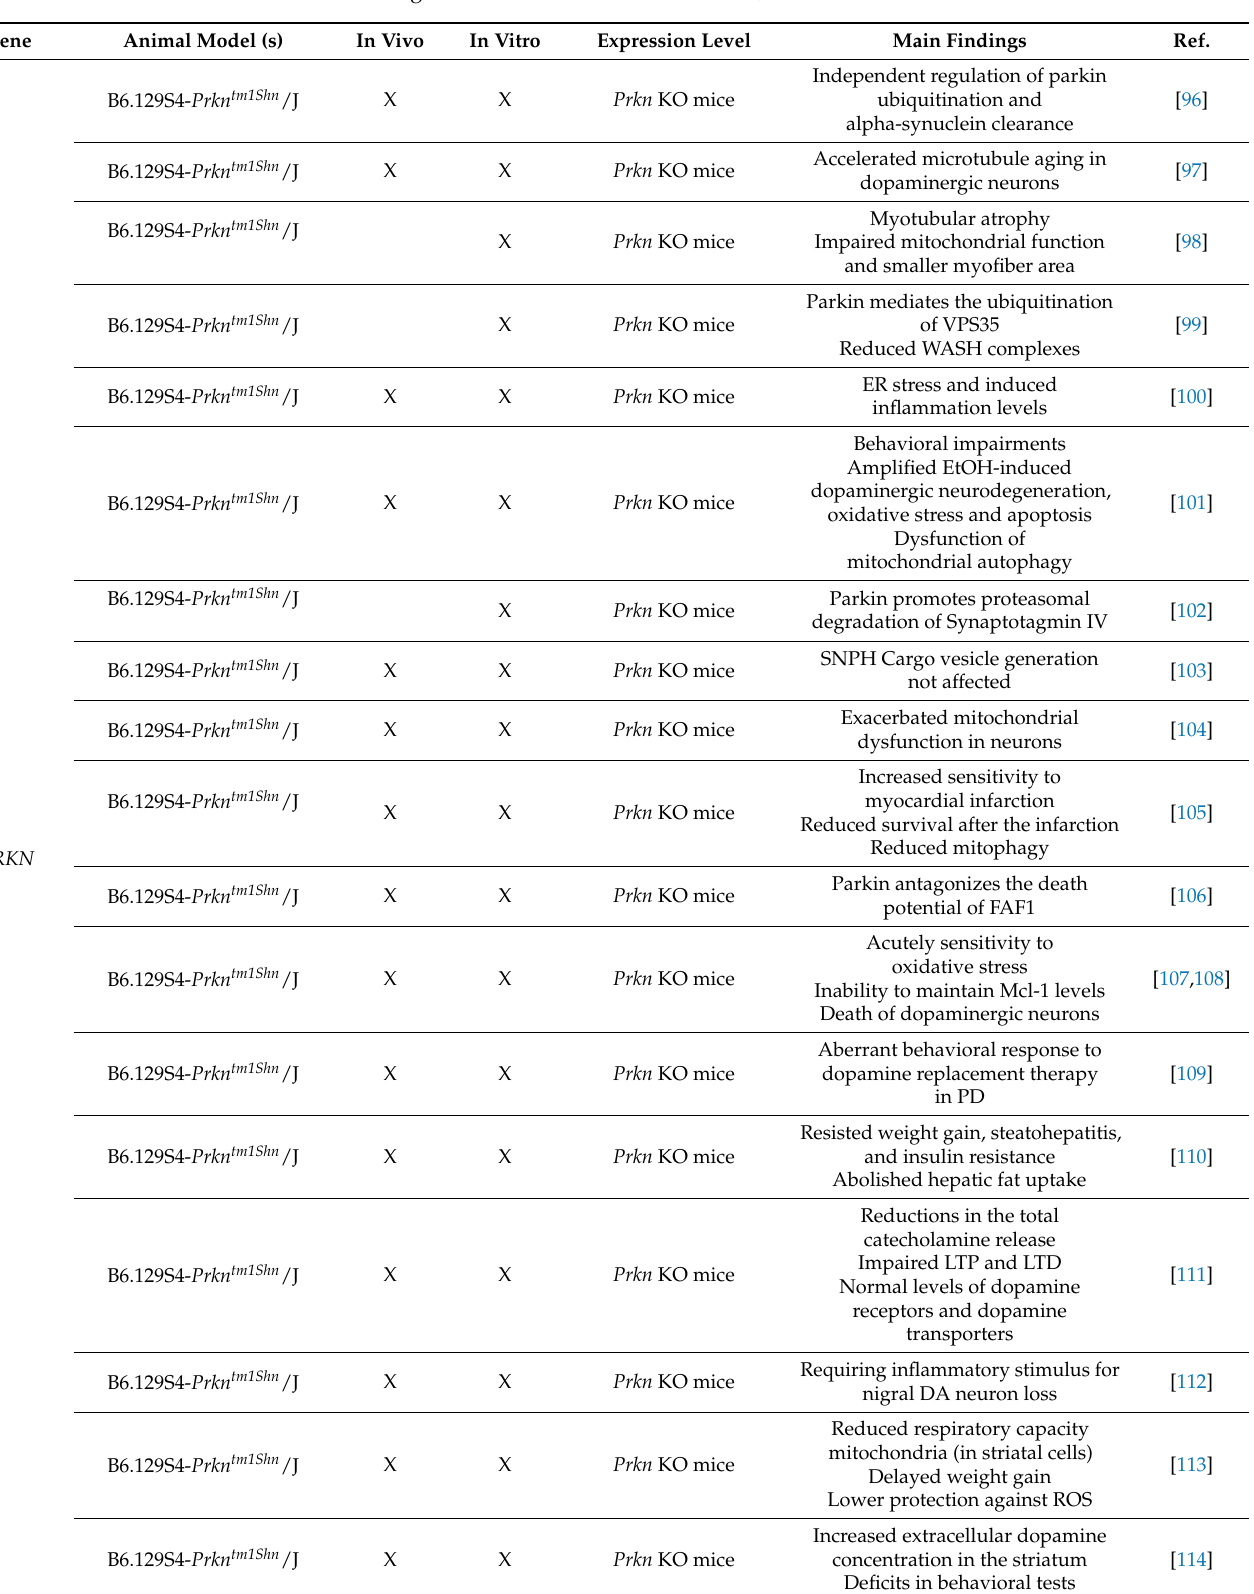
Table 4. Findings in animal models related to Prkn, Lrrk2 and